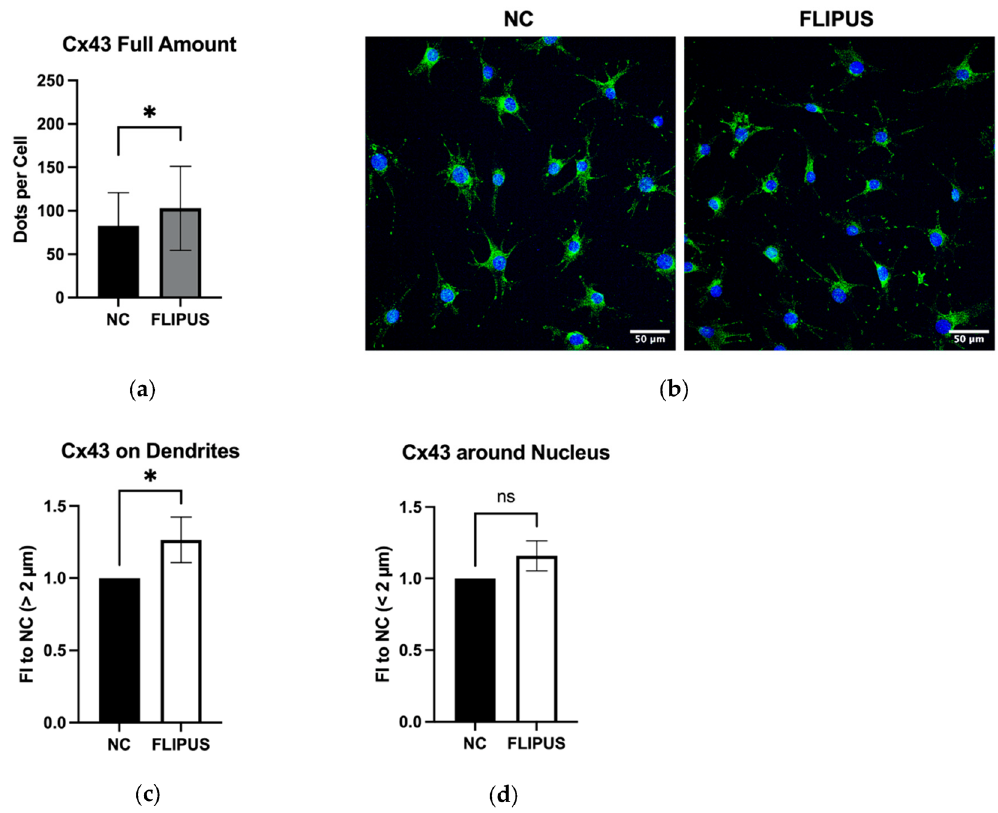
Figure 4. Stimulation with FLIPUS for 10 min enhances Cx43 protein expression on dendrites of starved MLO-Y4 osteocytes. ( a ) Representative images of Cx43 staining; ( b ) Quantification results of Cx43; ( c ) Normalized values of Cx43 expression on dendrites and cell body of osteocytes at the